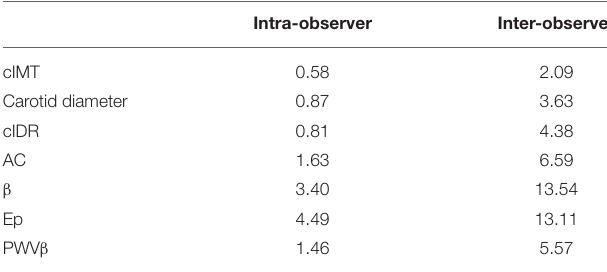
TABLE 3 | Intra- and inter-observer reliability of ultrasound parameters (coefficient of